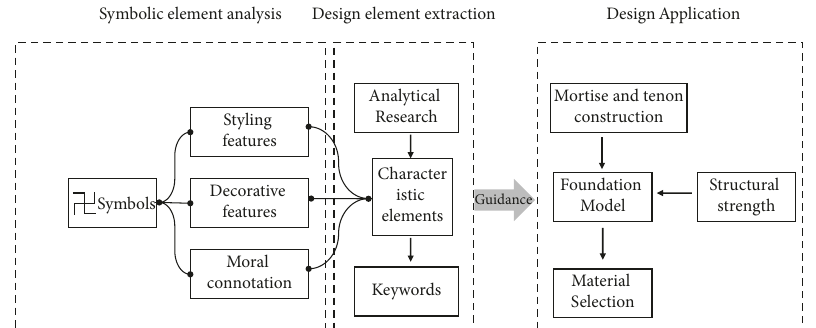
Figure 2: Design application